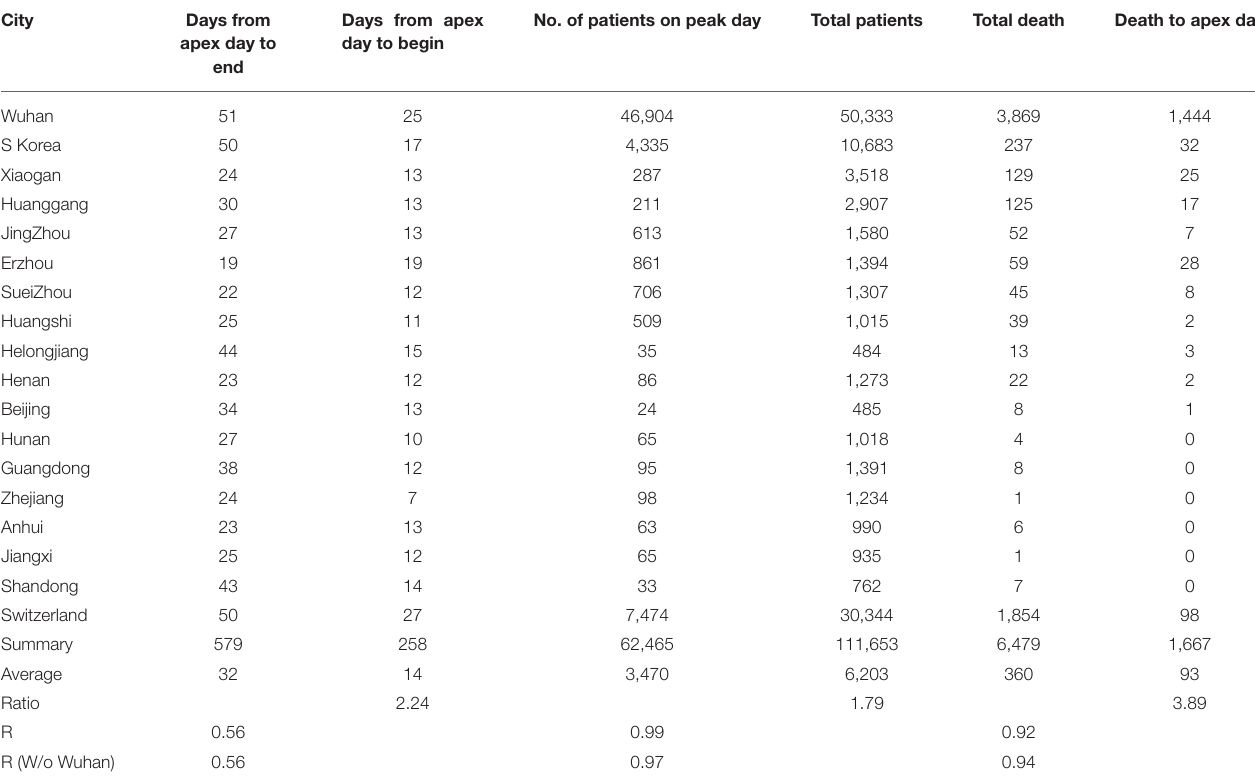
TABLE 1 | Information from pandemics in different cities, provinces, and countries for model construction. City Days from